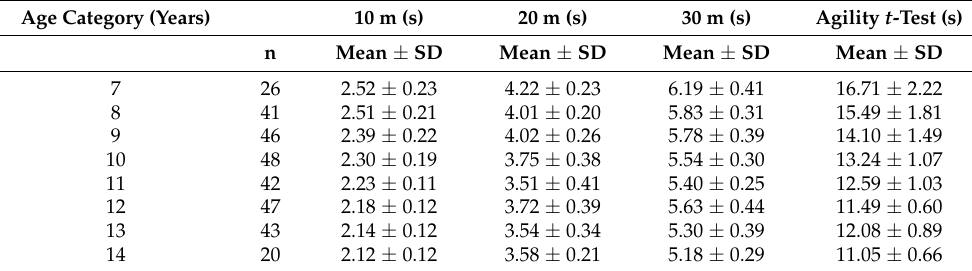
Table 3. Sprint and agility ( t -test).